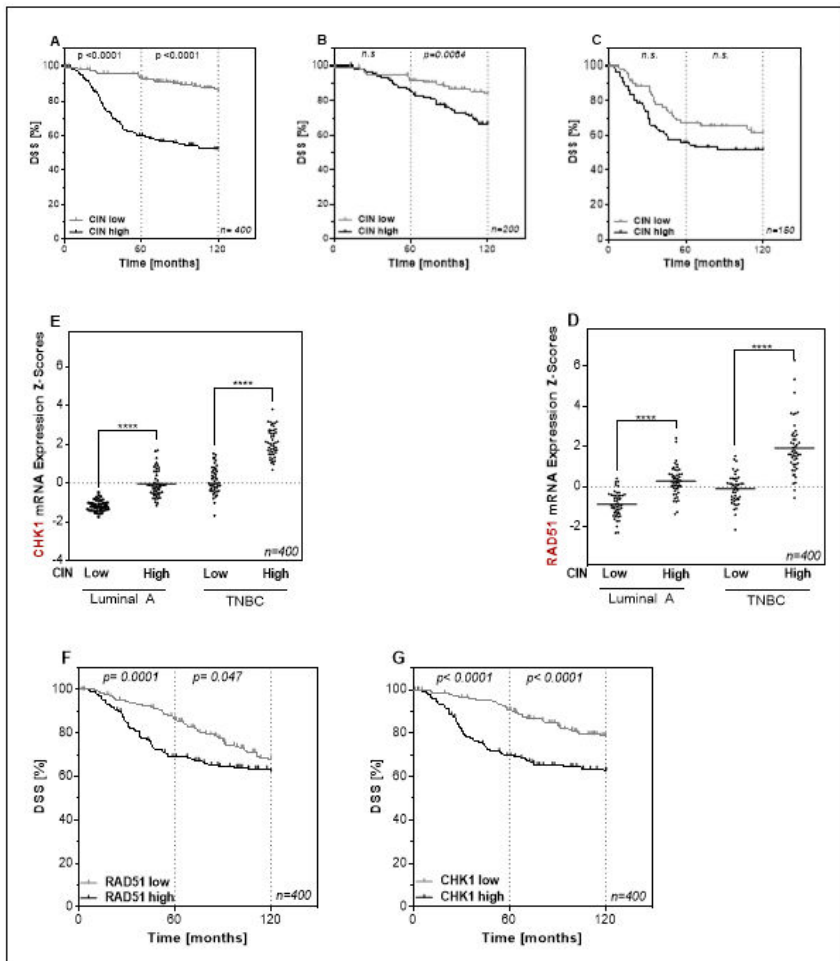
Figure 1. A high gene expression profile consisting of 70 genes associated with a functional aneuploidy (CIN70) score is negatively associated with disease-specific survival in luminal A (LumA) and triple-negative breast cancer (TNBC) subtypes and correlates with the expression of RAD51 and CHK1. ( A – C ). Kaplan–Meier analysis of the CIN70 score as prognostic factor for disease-specific survival (DSS) in breast cancer patients ( A ) ( n = 400) patients with LumA ( B ) ( n = 200) and TNBCs ( C ) ( n = 150) using the two extreme quartiles. The CIN70 score defines the di ff erential mRNA expression of 70 genes in tumors classified as stable and unstable based on their structural and numerical chromosomal alterations [3]. DSS is plotted against time after therapy. All, LumA and TNBC tumors with CIN high showed significantly worse 5- and 10-year DSS compared to tumors with CIN low, with 52% vs. 86% after 10 years for all, 84% vs. 67% after 10 years (n.s / p = 0.0084) for LumA and 52% vs. 62% after 10 years (n.s / n.s) for TNBC tumors. p -values were calculated on the basis of the log-rank test. ( D , E ). mRNA expression of RAD51 ( D ) and CHK1 ( E ) for LumA and TNBC tumors of the Metabric data set sorted by CIN70 score using the two extreme quartiles. RAD51 is expressed significantly higher in CIN high than in CIN low tumors, both in LumA, with − 0.88 ± 0.09 vs. 0.27 ± 0.1 and − 0.11 ± 0.01 vs. 1.92 ± 0.19, respectively. A significantly increased expression in CIN high compared to CIN low was also found for CHK1, with 1.17 ± 0.04 and − 0.03 ± 0.096 for LumA and 0.13 ± 0.1 vs. 2.08 ± 0.1 for TNBC. ( F , G ). Kaplan–Meier analysis of DSS of 400 patients according to the RAD51 ( F ) or CHK1 ( G ) expression using the two extreme quartiles. DSS is plotted against time after therapy. Patients whose tumor had a high expression of RAD51 showed significantly lower DSS compared to low RAD51 expression (68% vs. 62%). For the expression of CHK1, the negative e ff ect of a high expression on survival was even more evident (62% vs. 80%). p -values were calculated on the basis of the log-rank test (**** p < 0.0001; Student’s t